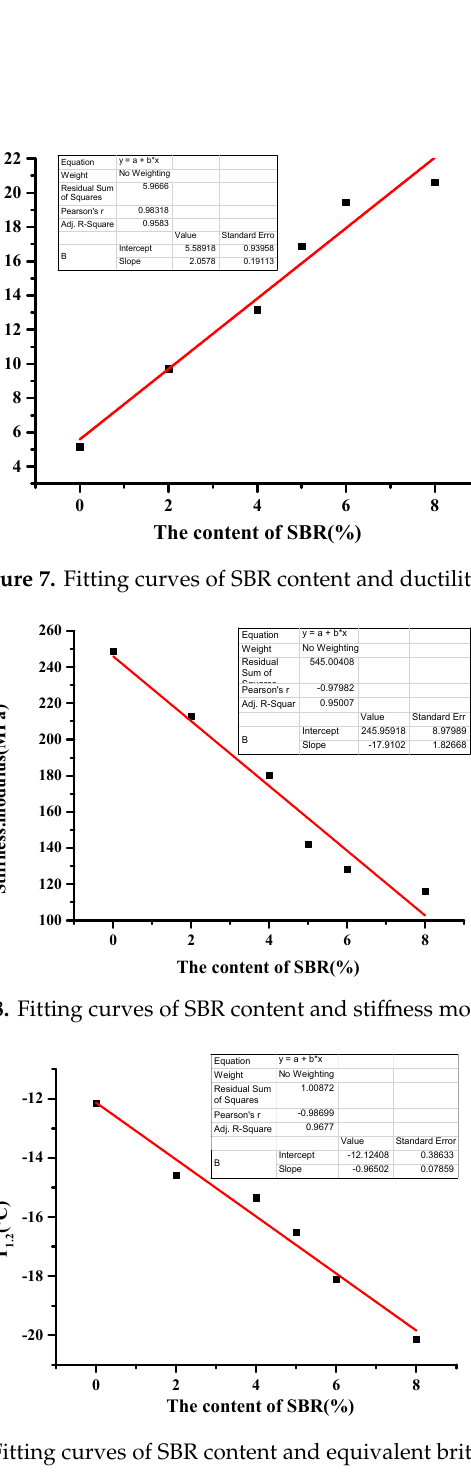
Table 20. Performance Index of BRA–SBR composite modified asphalt.